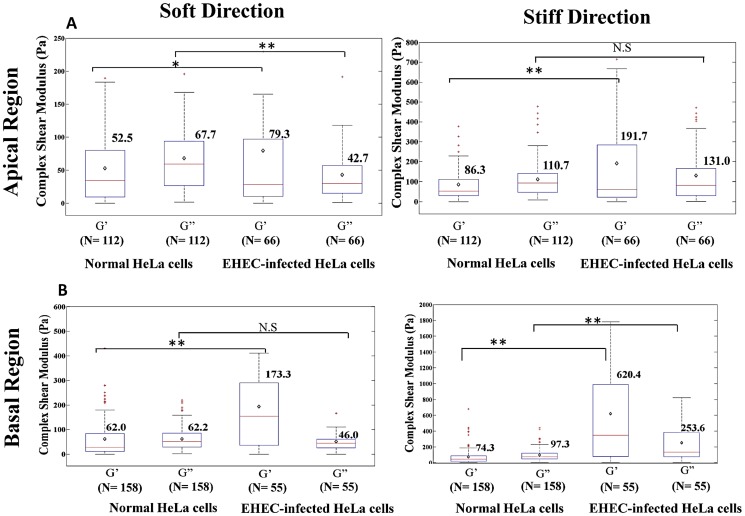
Boxplot of intracellular elastic shear modulus G′ and viscous shear modulus G″ (at 10 Hz) of HeLa cells without vs. with EHEC infection.Left: along the soft axis, and Right: along the stiff axis; (A) the apical region, and (B) the basal region. *: p<0.05; **: p<0.001. The symbol “⋄” and the horizontal bar inside each box represent the mean and the median values, respectively; and the lower and the upper sides of each box represent the values at the first and the third quartiles, respectively.